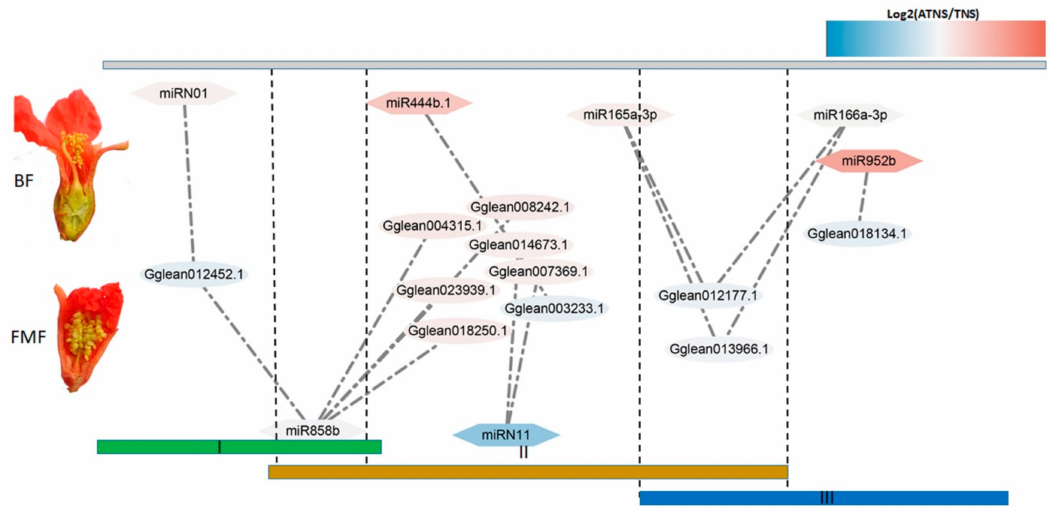
Figure 6. Pomegranate miRNA-mediated interaction network during BFs and FMFs pistil development stages. I, ATNSI and TNSI; II, ATNSII and TNSII; and III, ATNSIII and